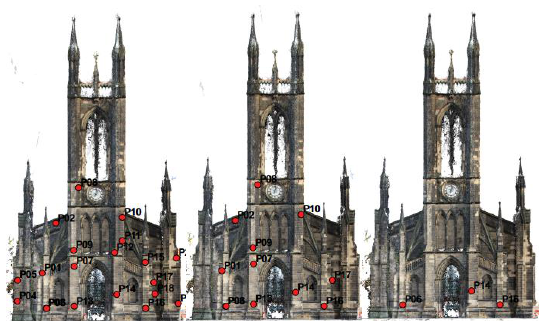
Figure 3. Configuration of the 20, 12 and 3 control points (left to